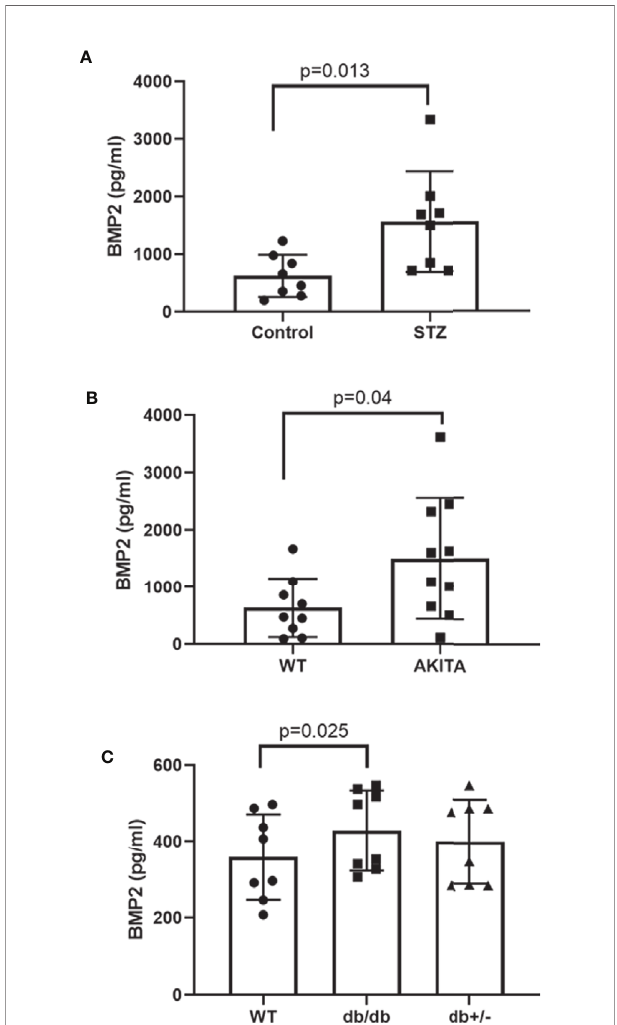
FIGURE 1 | Measurement of circulating levels of BMP2 by ELISA. Unpaired t-test was used to compare the plasma levels of BMP2 in streptozotocin (STZ) or Akita diabetic mice compared to control. Data analysis showing signi fi cant increases STZ-diabetic ( A , p value=0.013), and 12-months diabetic Akita mice ( B , P=0.04). For multiple comparison, we used one way ANOVA followed by Tukey test to analyze the difference in plasma levels of BMP2 between db/db (6 week diabetic), db/+, and control. There was signi fi cant modest increase in the levels of plasma BMP2 in db/db compared to the control ( C , p value = 0.025). There was no signi fi cant difference between db/db and db/+. n=8 –